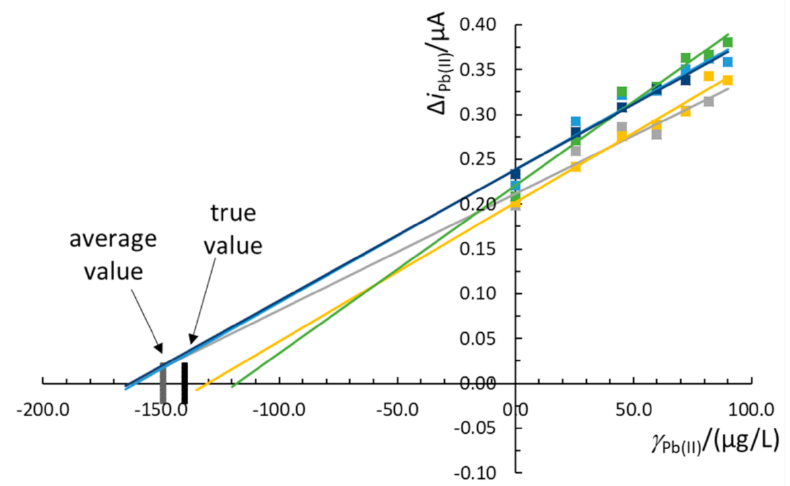
Figure 3. Method of multiple standard addition using the BiFSPE for the determination of γ Pb(II) in a single drop of solution consisting of the 0.1 M acetate buffer spiked with 140.0 µ g/L Pb(II).